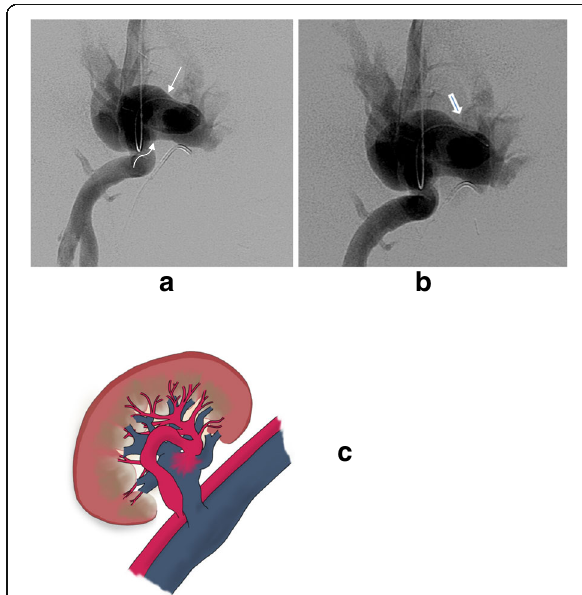
Fig. 1 Angiographic and schematic demonstration of high flow arterio-venous fistula within the transplanted kidney. a Aneurysmal intra renal artery (white arrow) and relative narrowing at the AVF connection (curved arrow) demonstrated on pre-procedure angiography. b Left lateral oblique view shows early draining aneurysmal renal vein (solid arrow). c Schematic diagram demonstrating the high flow AVF within the transplant kidney and highlighting the tortuous vessel